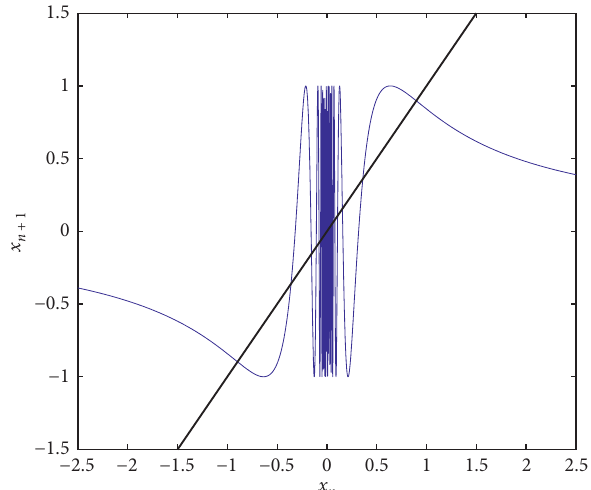
Figure 1: Phase diagram of fractional map (8) for μ � 1 , A � 0 . 5 , B � 0 , C � 1.